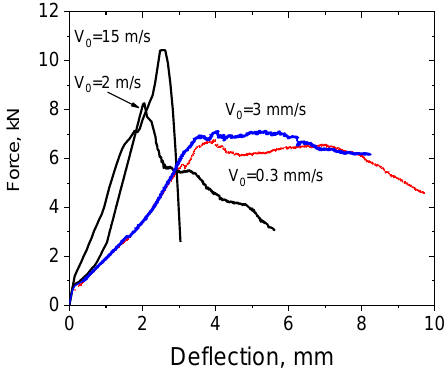
Figure 5. Experimental F( u z ) diagrams for Ti-5Al-2.5Sn.